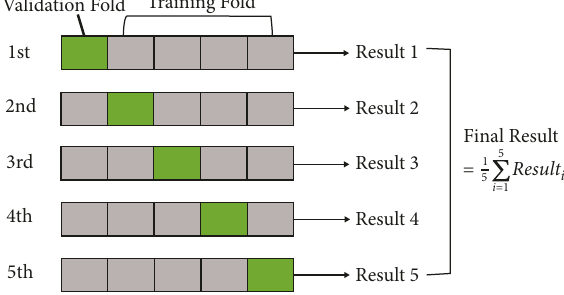
Figure 1: K -fold cross-validation